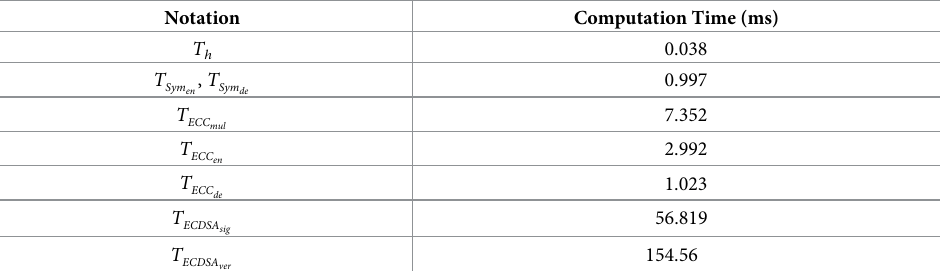
Table 4. Computation time of each